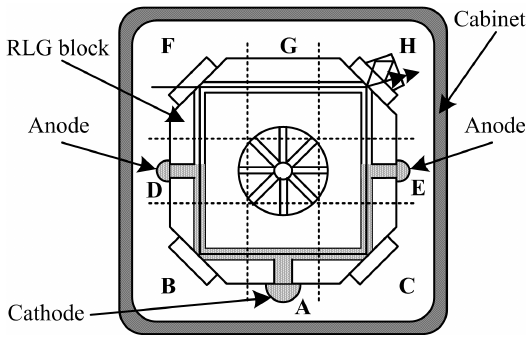
Figure 2. Thermometer arrangement in RLG.